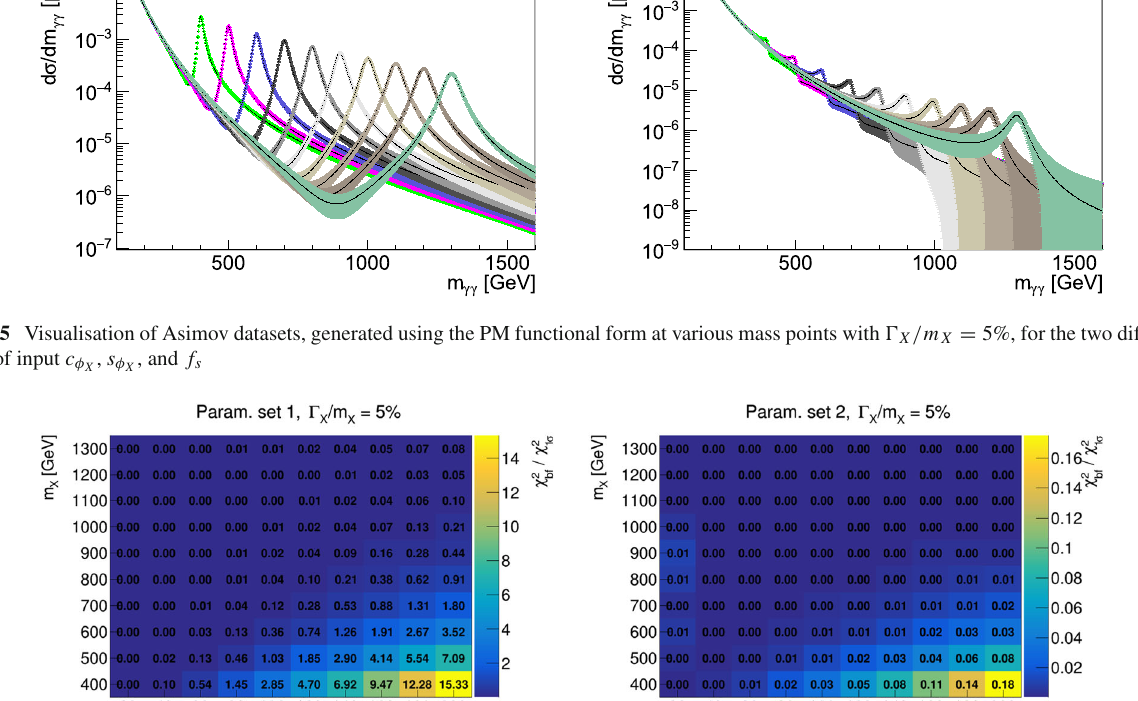
plot, and shows the ratio of best-fit χ 2 to the 1 σ cut-off. Lower values indicate better fits. Left (right) panel: the result using set 1 (2) of the input PM parameters